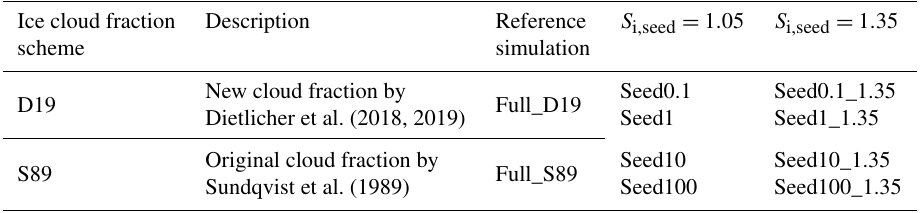
Table 3. Experimental set-up for cirrus seeding for the two ice cloud fraction schemes. Both configurations include seeding particle con- centrations of 0.1, 1, 10, and 100 L − 1 . In addition, seeding is conducted for seeding particle critical ice saturation ratios ( S i ) of 1.05 and 1.35. The “Full” in the reference simulations refers to full ice nucleation competition between pre-existing ice, heterogeneous nucleation on mineral dust particles, and homogeneous nucleation of liquid sulfate aerosols in the in situ cirrus scheme (Kärcher et al., 2006; Kuebbeler et al.,